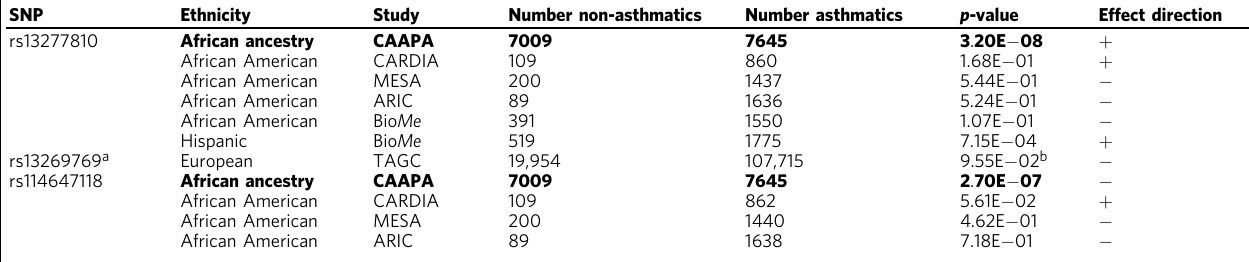
Table 3 Summary of tests for replication for two novel loci on chromosome 8 with p -values < 10 − 6 in the CAAPA